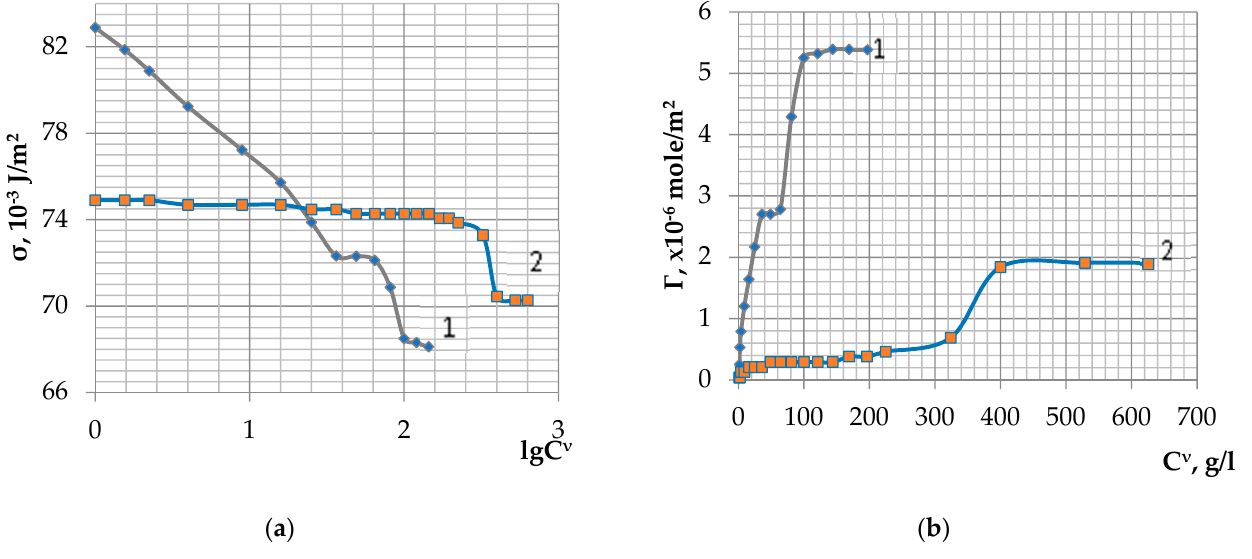
Figure 19. Characteristics of the plasticizer in waters No. 1 (soft) and No. 2 (hard): ( a )— σ = f(lgC ν ); ( b )— Г = f (C ν ).